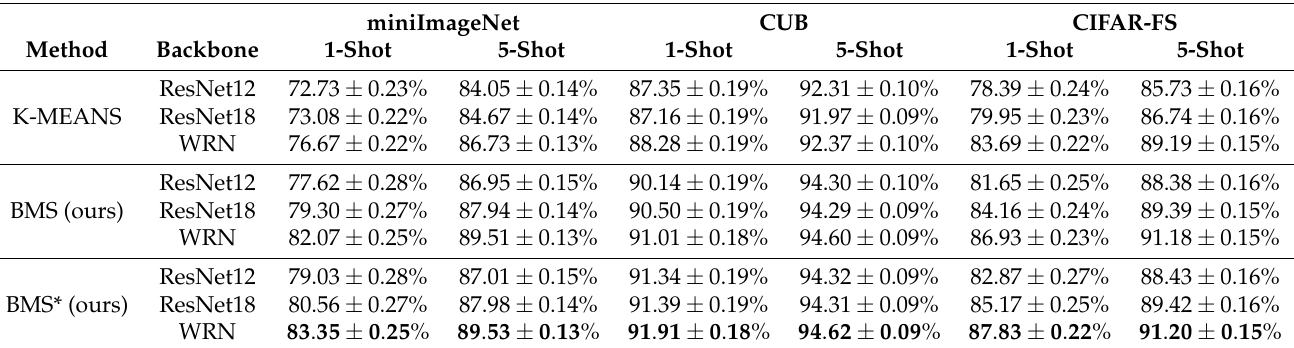
Table 5. The 1-shot and 5-shot accuracy of the proposed method on different backbones and bench- marks. Comparison with the k-means algorithm. Best results are in